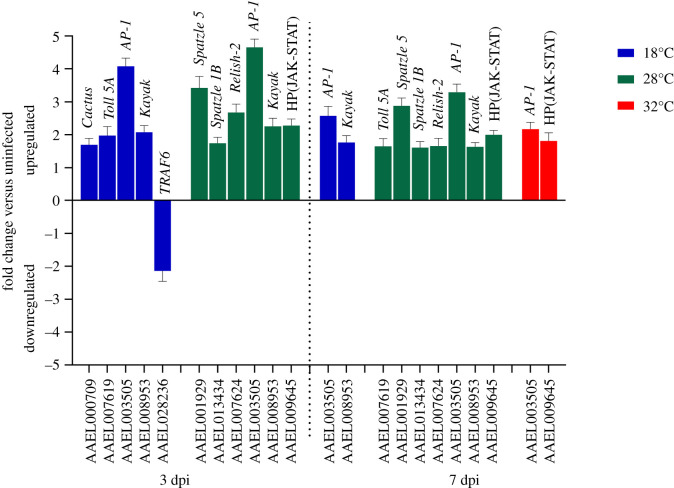
Differentially expressed genes (DEGs) related to immune signalling at (a) 3 dpi and (b) 7 dpi, in CHIKV-infected Ae. aegypti versus uninfected controls. HP indicates hypothetical protein. Error bars represent standard error of the mean.